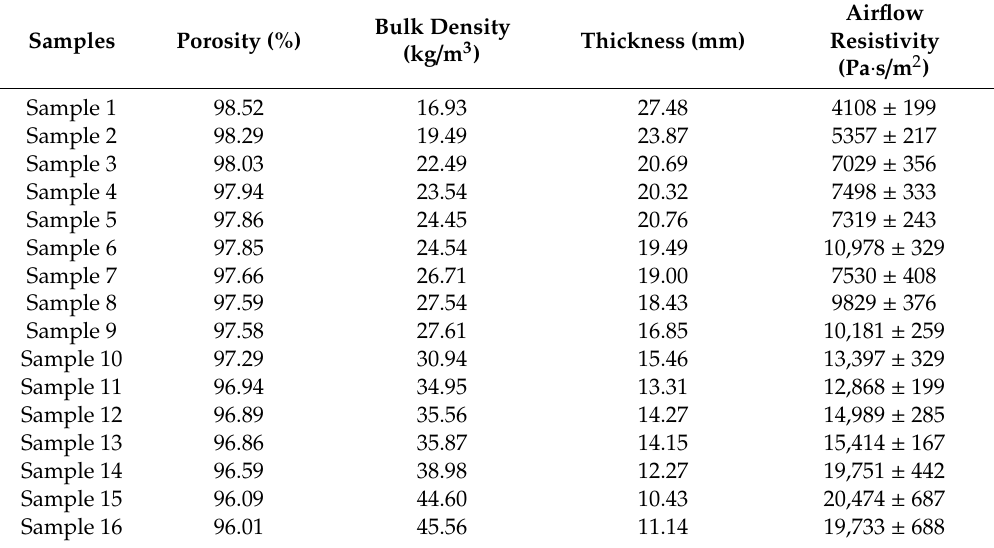
Table 1. Characteristics of polyester